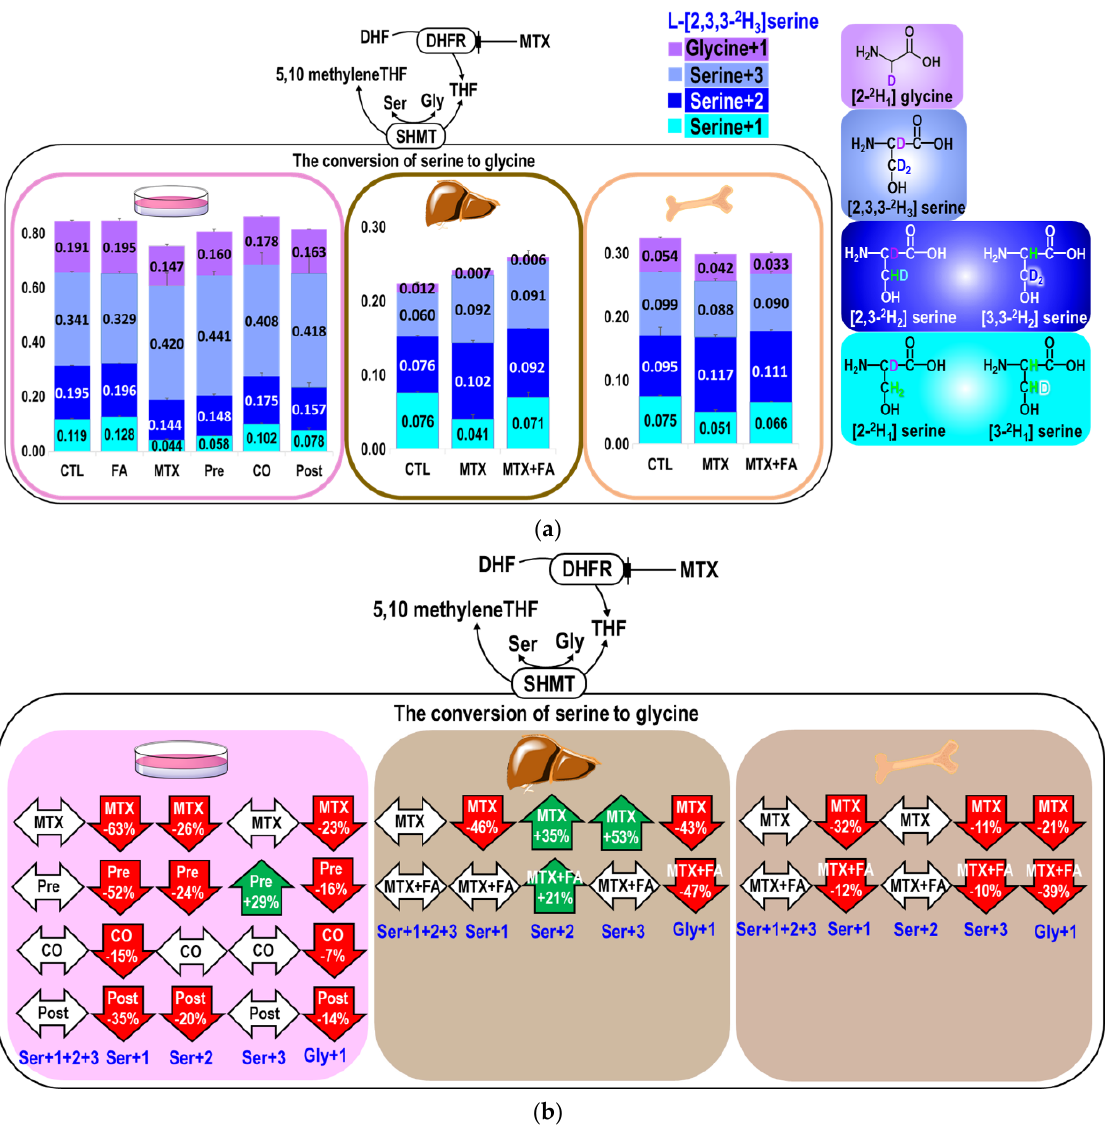
Figure 2. Effects of MTX on the conversion between serine and glycine in vitro and in vivo. ( a ) The upper panel shows the isotopic distributions of serine (Ser+1, +2, +3) and glycine (Gly+1) from tracer L-[2,3,3- 2 H 3 ]serine in cell and mouse tissues treated with MTX and folinate. Enrichment of serine isomers (including serine+1 in cyan, serine+2 in blue, serine+3 in cornflower blue) and glycine (purple) were plotted as cumulative bar charts, under treatments of MTX and folinate in the cell model, mouse liver, and bone marrow. The isotopic distributions in glycine and serine isomers changed by MTX and folinate despite that the total of all serine isotopic species (Ser M+1+2+3) was nearly unchanged. Error bars represent the standard error of the mean. The chemical structure of isotopic serine isomers and glycine are illustrated on the right with the designated color. ( b ) The lower panel shows the percent changes in the isotopic enrichments in each target compound compared to the control cells/animals that received phosphate-buffered saline (PBS).